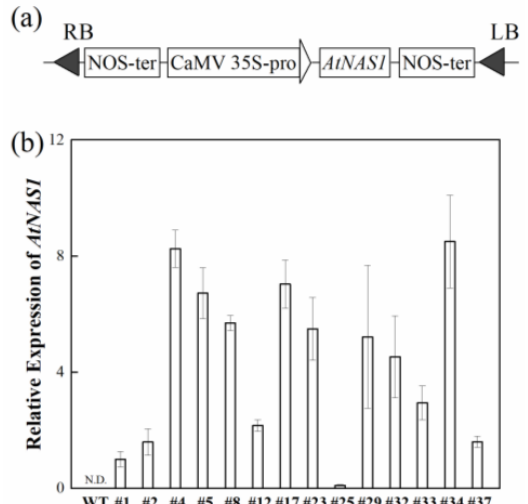
Figure 1. Confirmation of 35S::AtNAS1 transgenic potato. ( a ) Schematic representation of the T- DNAs used for constitutive overexpression of the AtNAS1 gene. RB, right border; NOS-ter, nopaline synthase terminator; CaMV 35s pro, dual CaMV 35S promoter; AtNAS1 , coding sequence of AtNAS1 (975 bp); LB, left border. ( b ) Expression of AtNAS1 in independent transgenic potato plants and wild-type (WT) plants, determined by quantitative real-time PCR analysis. Actin (XM_006350963) was used as an internal control to normalize the expression of the transgene. The data represent means from three biological replicates. Error bars = standard deviation (SD).